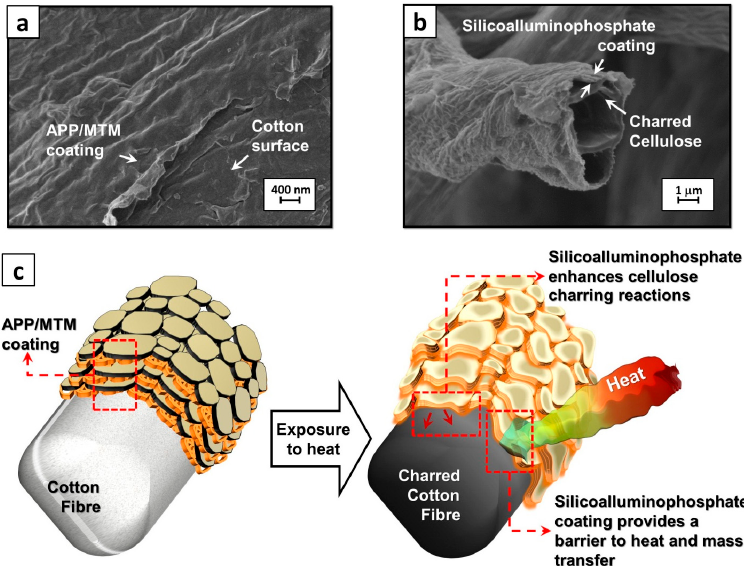
Figure 7. Coating reaction to heat or flame application: FE-SEM micrograph of coating (5% APP/MTM)) before combustion ( a ); SEM micrograph of expanded coating (5% APP/MTM) after combustion ( b ); and schematization of the coating flame retardant action ( c ).